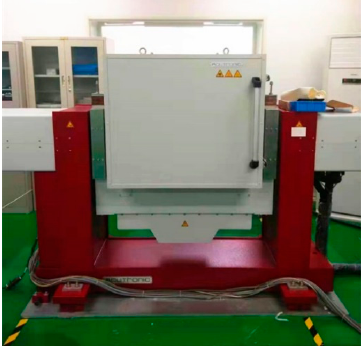
Figure 5. The two-axis turntable with a thermal chamber.